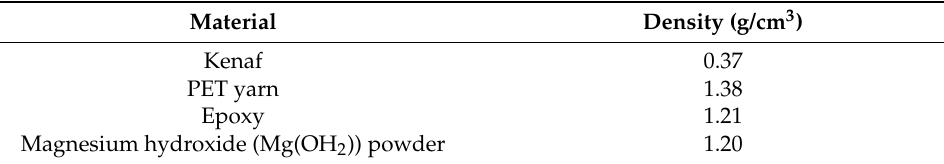
Table 2. Densities of materials used.